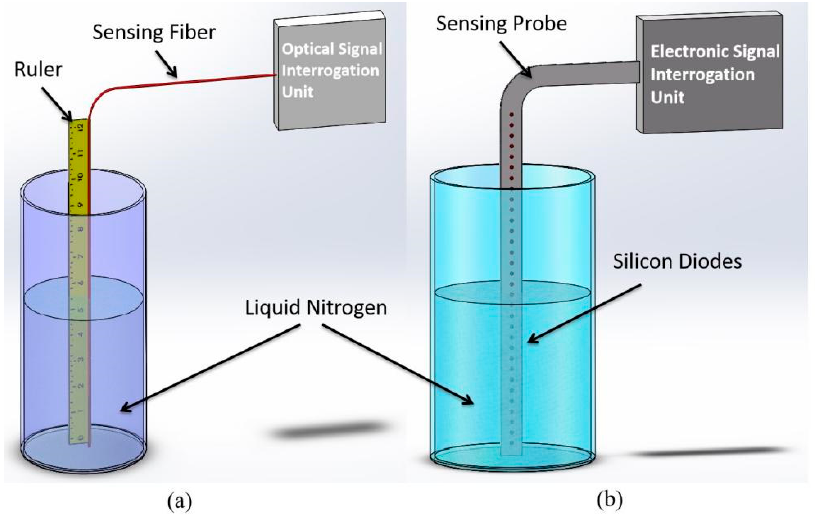
Figure 1. ( a ) Schematic experimental setup used for measuring liquid level using the optical fiber sensor. Liquid level was measured with a ruler and the fiber sensor (red line in the figure); ( b ) liquid level was measured with a silicon diode sensing probe, which consists of tens or hundreds of silicon diodes (black dots in the